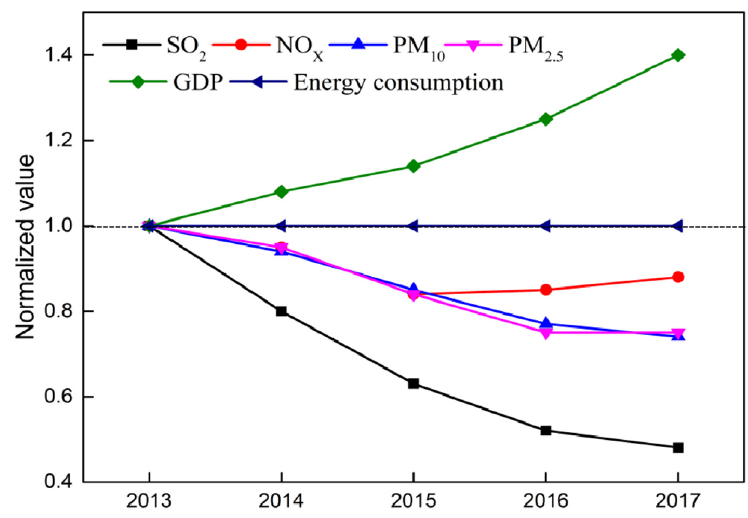
Figure 2. Trends in pollutant emissions, GDP, and energy consumption in Sichuan, all data were normalized to the year 2013.